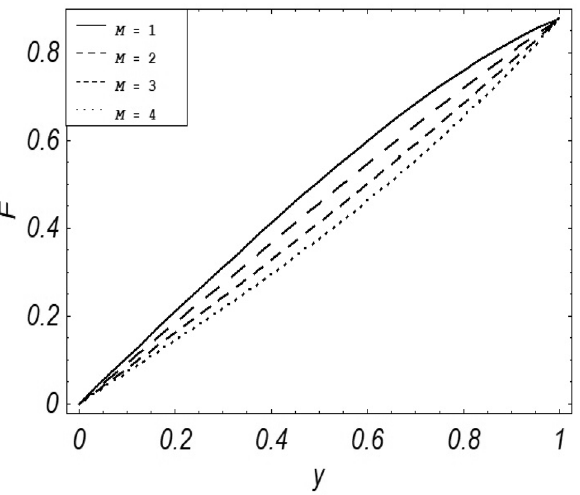
Figure 3. Evolution of F with various values of M if t = 1 ; Gr = 2.5 ; N = 0.7 ; K = 0.5 ; η = 2 � = 0.5 ; Re = 1 ; α = 0.1 ; ω = 0.5 ; ε = 0.001 .